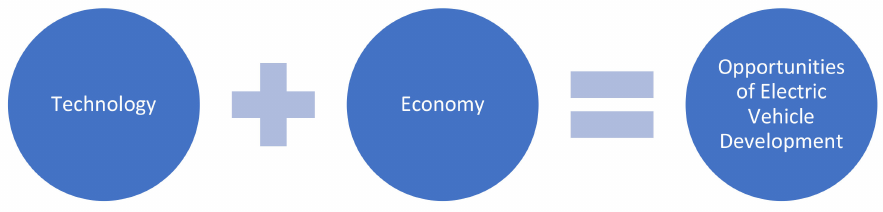
Figure 2. Opportunities of Electric Vehicle